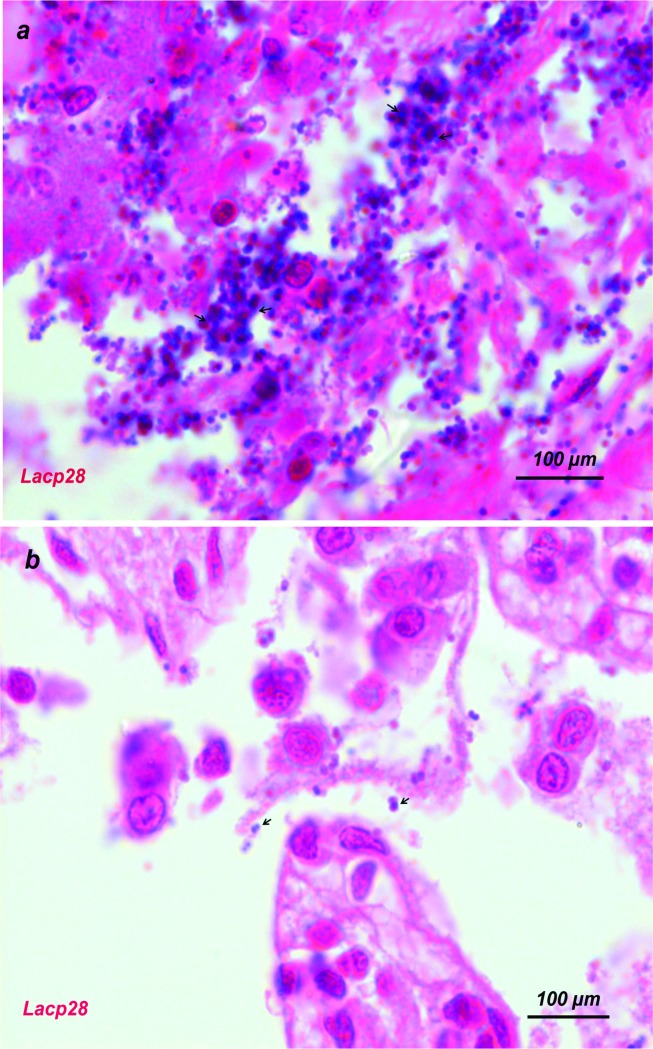
In vitro adhesion of the isolates (Lacp28) to epithelium cells of pig's ileum (a) and chicken intestine (b) after treatment with cell suspension (1x109 cfu/ml). Magnification, X400.